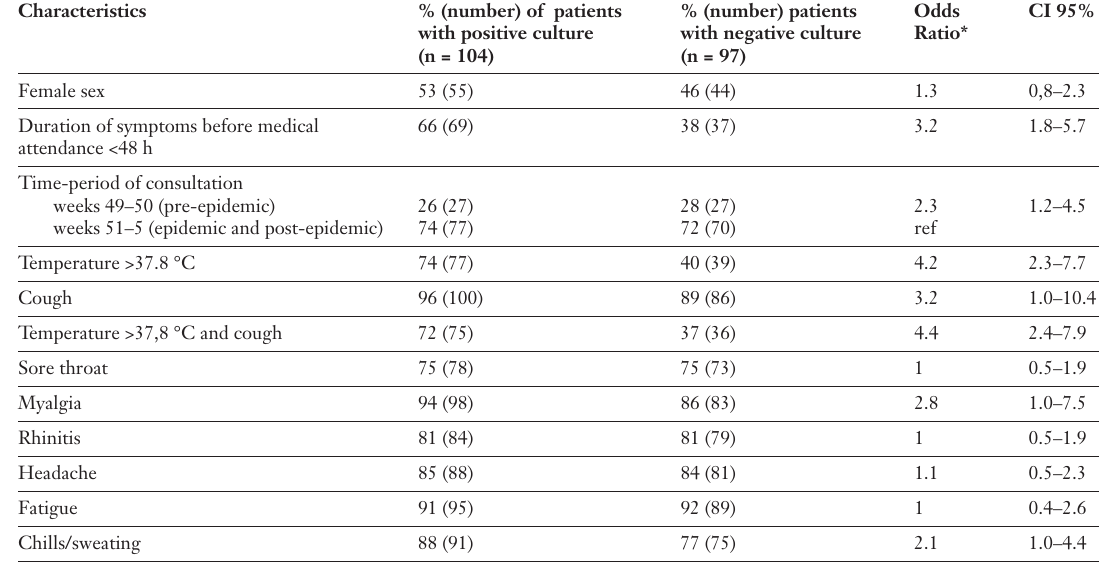
Table 1 Demographical characteristics and prevalence of symptoms and signs among cases of in- fluenza (culture +) vs controls